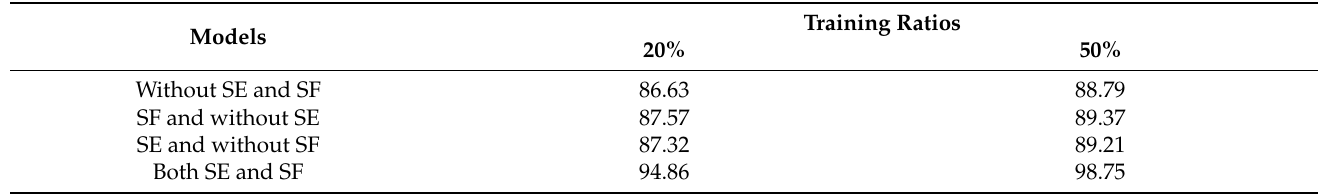
Table 7. Influence of socio-economic semantic features and shallower features on classification accuracy.